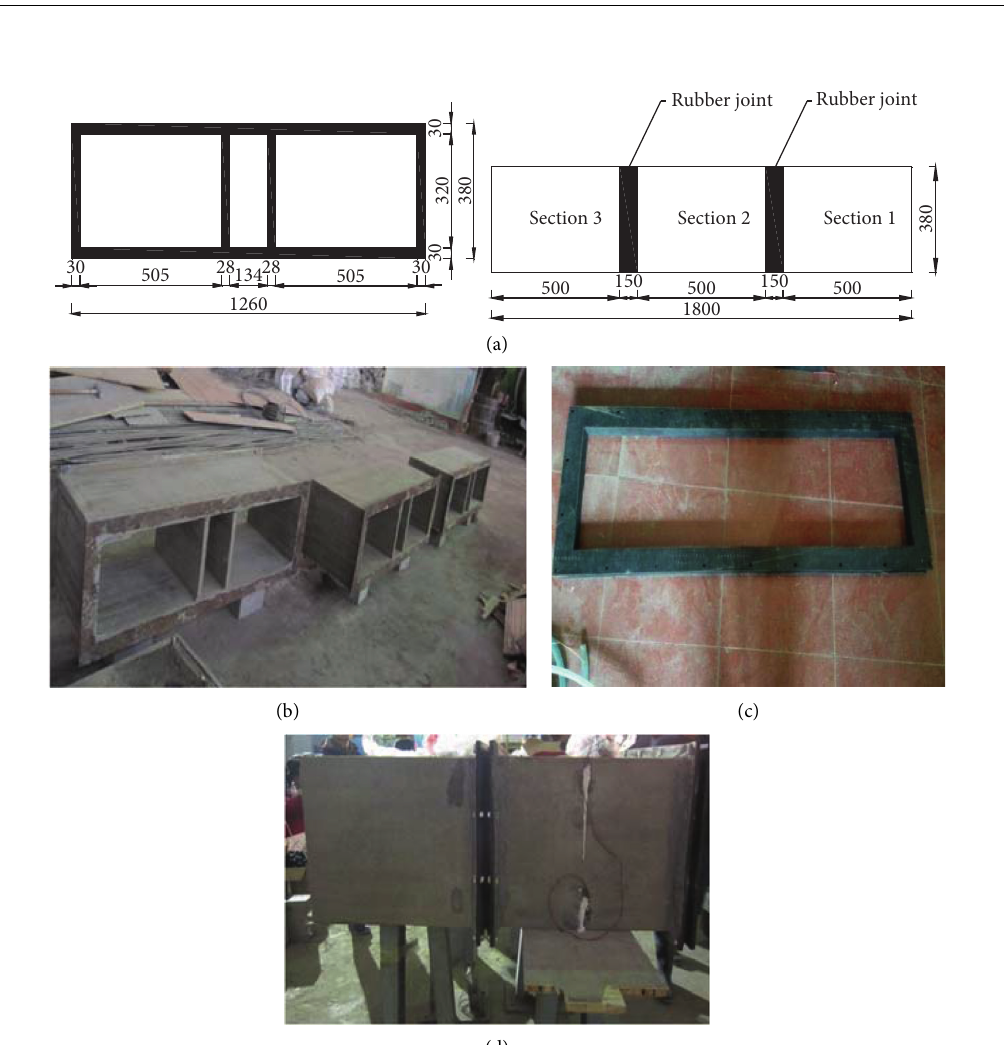
Figure 1: Test 1 structural model. (a) Tunnel cross section and vertical section dimensions